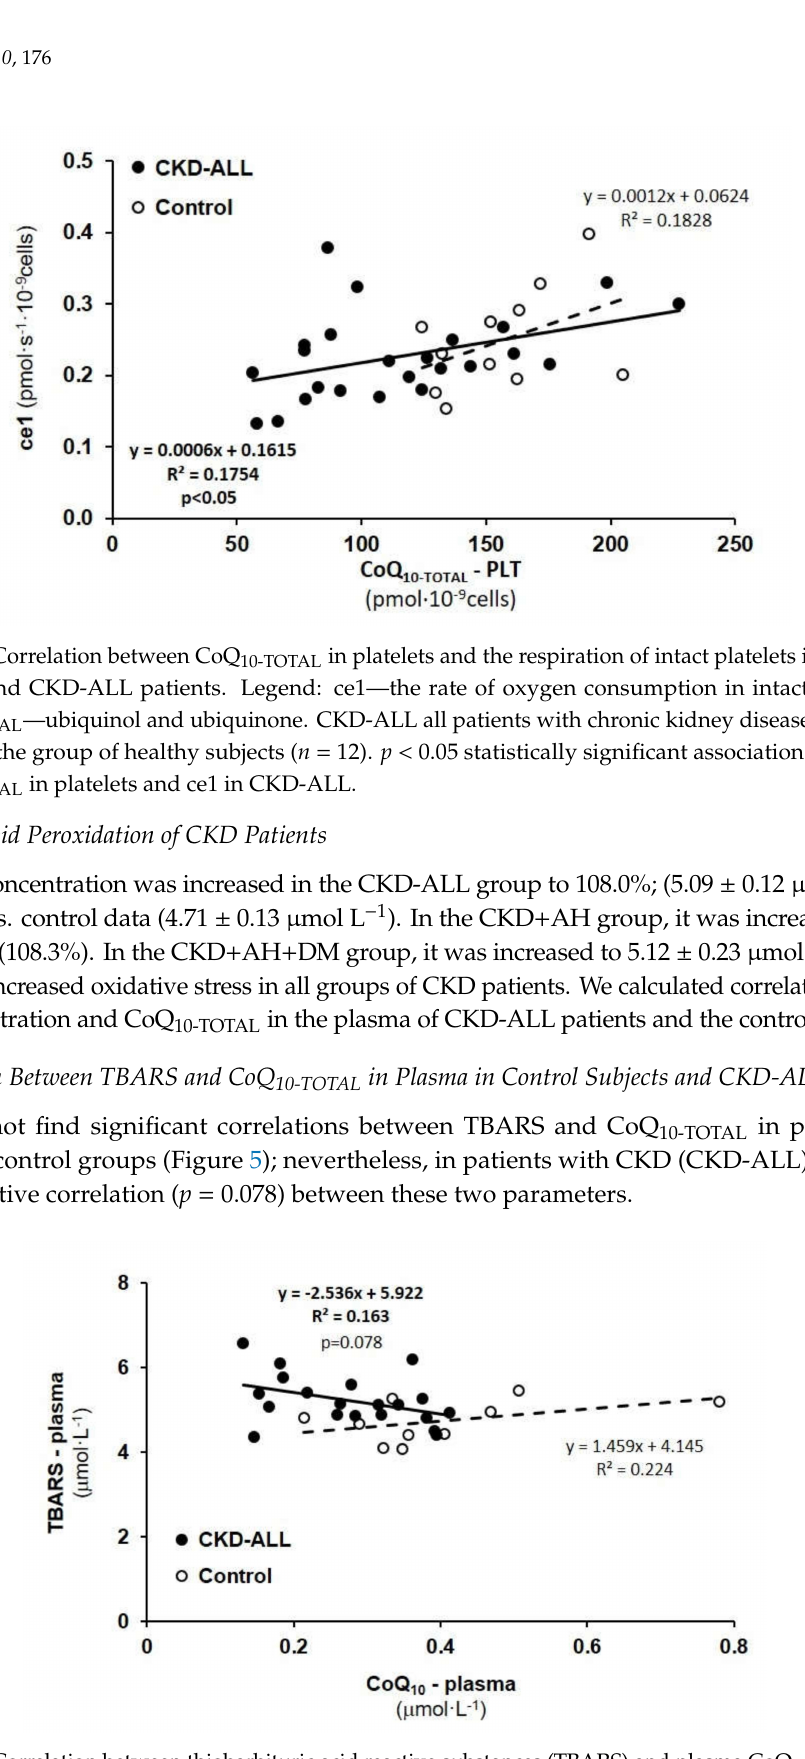
Figure 5. Correlation between thiobarbituric acid reactive substances (TBARS) and plasma CoQ 10-TOTAL in control subjects and CKD-ALL patients. Legend: CoQ 10-TOTAL —ubiquinol and ubiquinone. CKD-ALL—all patients with chronic kidney disease ( n = 27); Control—the group of healthy subjects ( n =